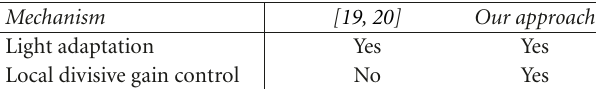
Table 1: Model overview : an overview over the mechanisms used in the model of Grossberg and Hong [19, 20] and our